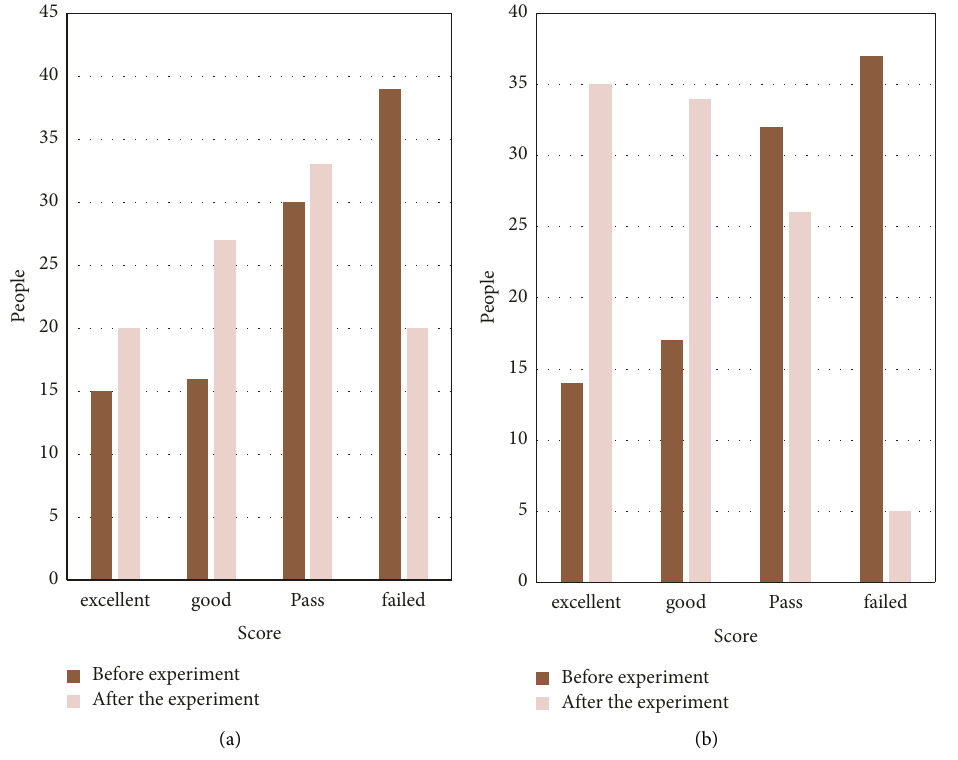
Figure 5: The final test scores of the two groups. (a) Group A test score. (b) Group B test scores.